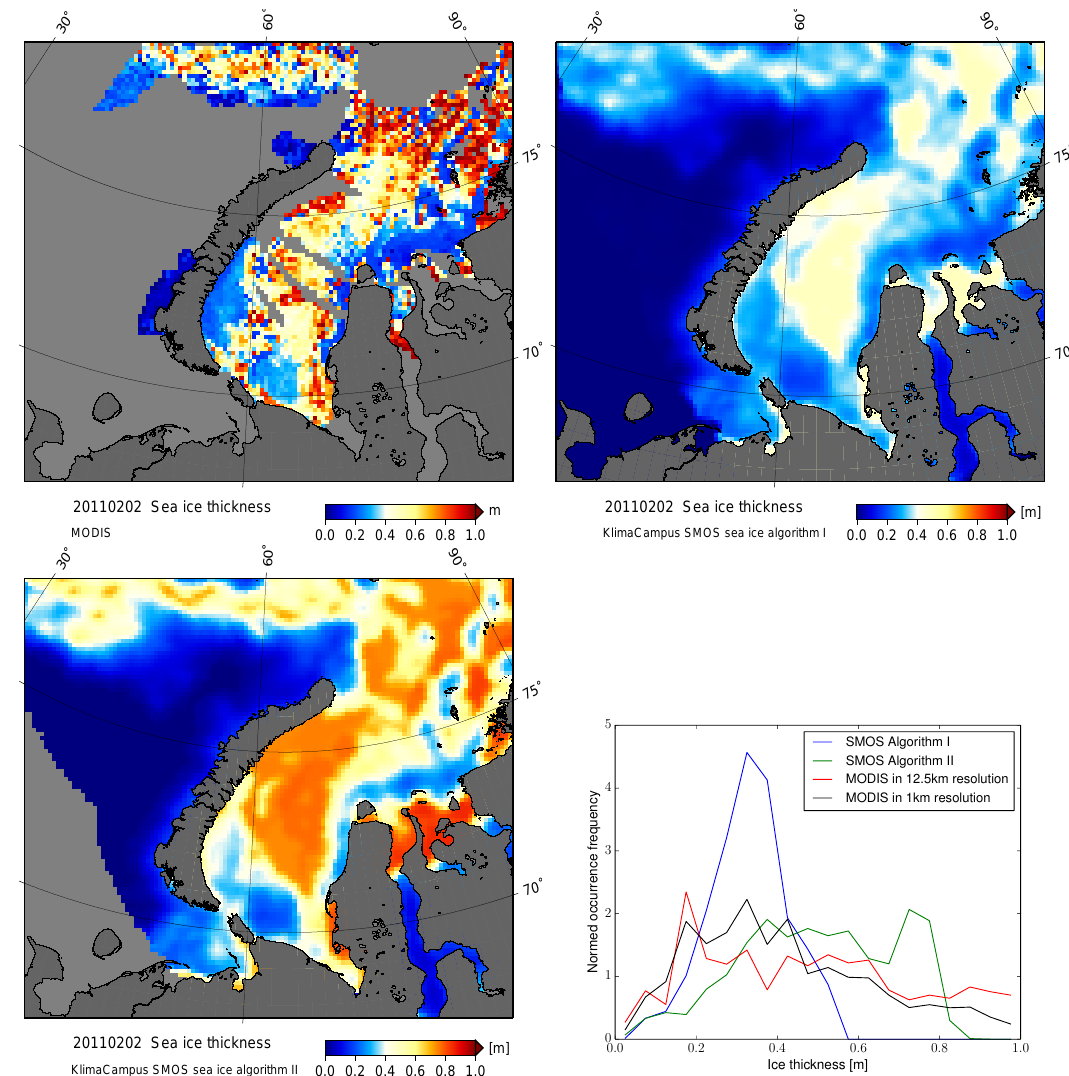
Figure 18. The modal MODIS ice thickness in 12.5km grid resolution (upper left), SMOS ice thicknesses retrieved from Algorithm I (upper right) and II (lower left), and the histogram of the three ice thickness data (lower right) in the Kara Sea on 2 February 2011.